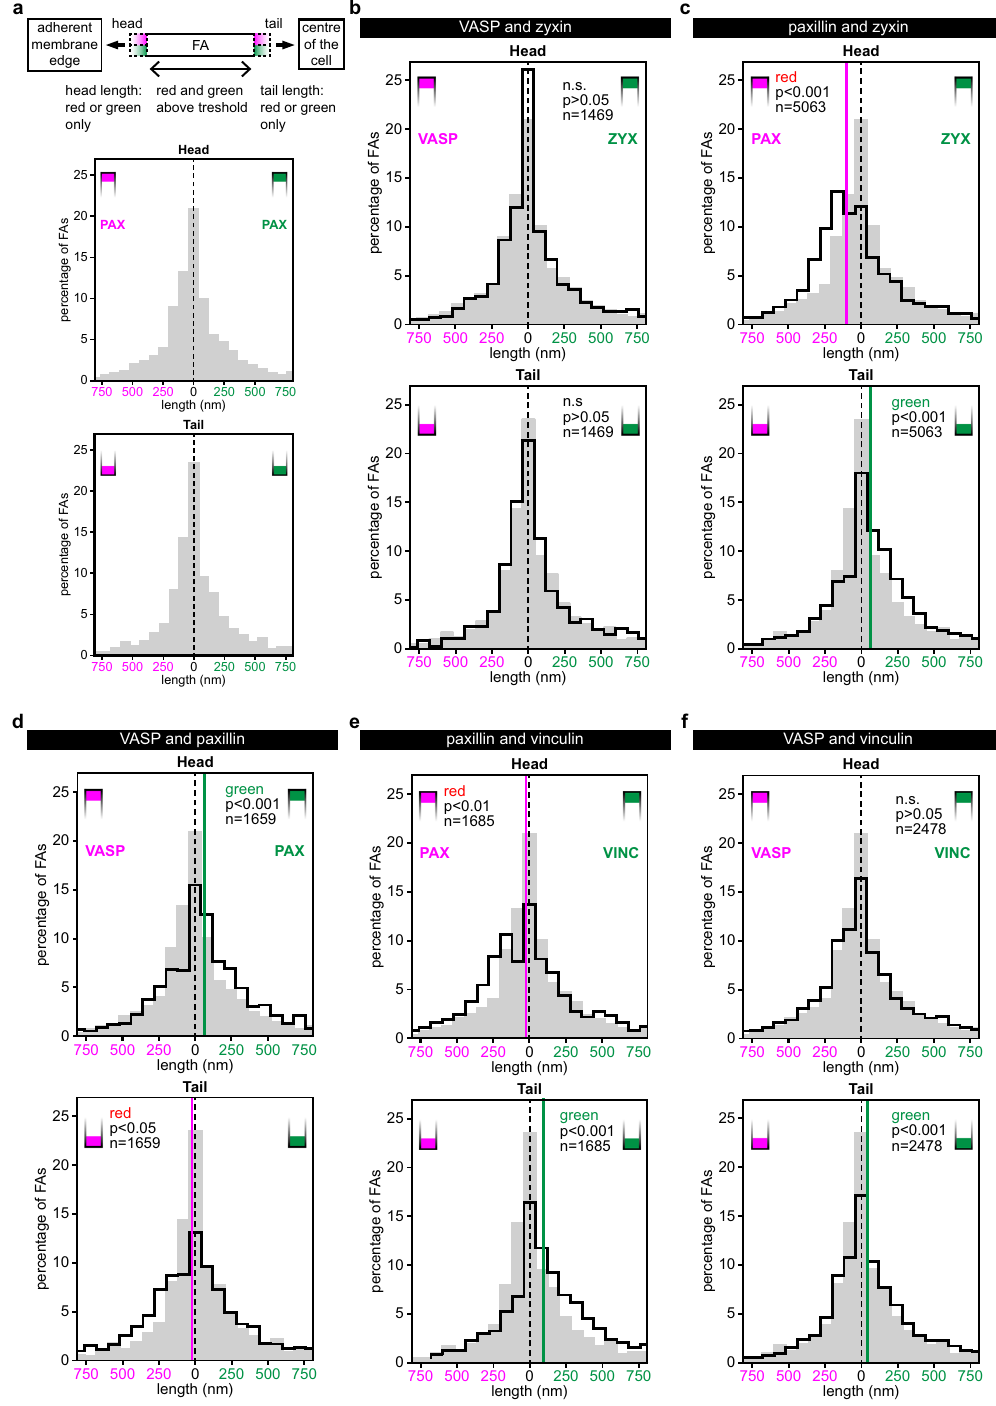
Figure 3. Histograms of the distribution of head and tail protrusion lengths. ( a ) Top panel: schematic representation of an FA in the two colour SIM images clarifying the method. Bottom panels: pax/pax reference histograms showing the distribution of the apparent head (top) and tail (bottom) protrusion lengths measured in the SIM images of the pax/pax reference set of U2OS cells co-expressing paxillin-mCherry and paxillin-GFP. These histograms are further systematically shown in grey in each presented histogram in all figures. ( b – f ) Histograms of FA head and tail protrusion lengths for the indicated protein pairs co-expressed in U2OS cells. Red protrusion lengths are plotted from right to left (i.e. negative green protrusion lengths) and green from left to right. The p values are generated by comparison of the experimental histogram (black line) and the reference histogram (grey) in two-sided Mann Whitney U tests, n represents the number of analysed FAs. Vertical lines: significant median protrusion lengths. Number of imaged cells from b to f: 15, 52, 17, 18 and 23. The pax/pax reference histograms are shown in